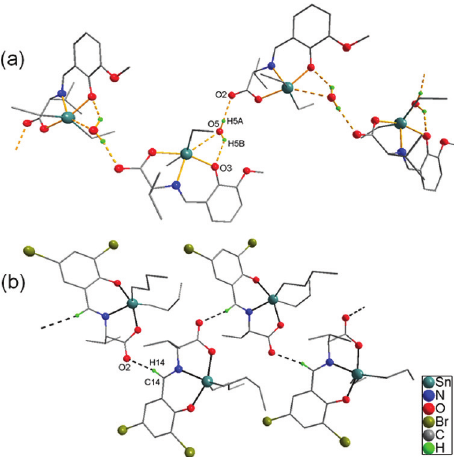
Figure 5: The 1D supramolecular chain in 3 (cid:1101) H formed by the intermolecular O–H (cid:1101)(cid:1101)(cid:1101) O or C–H (cid:1101)(cid:1101)(cid:1101) O hydrogen bonds. Hydrogen atoms are omitted for